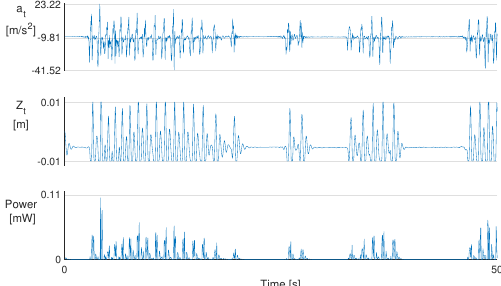
Figure 8. Movements of high accelerometer signals ( top ) axis corresponds to large displacements ( middle axis ) and higher resulted powers ( bottom ). Only when movement is present in the accelerometer signal, power can be generated according to the analytical